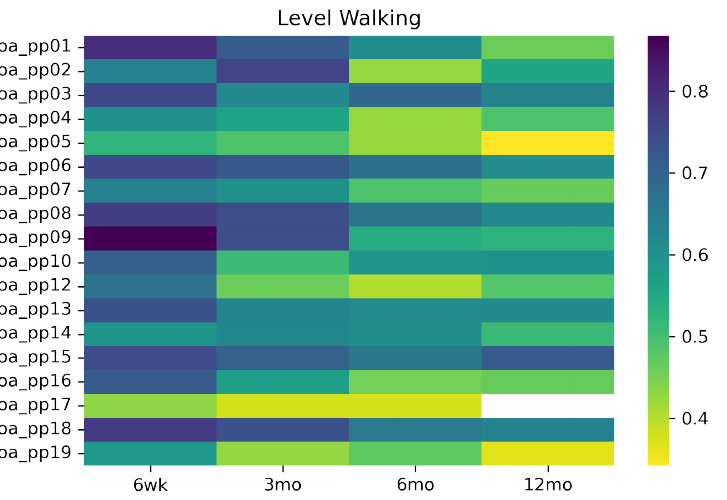
Figure 2. Heatmap of the probability of belonging to the patient class for each individual. Darker colours indicate a high probability of belonging to the TKA class, and the lighter the colours lower the probability. The model was developed on post-operative data of level